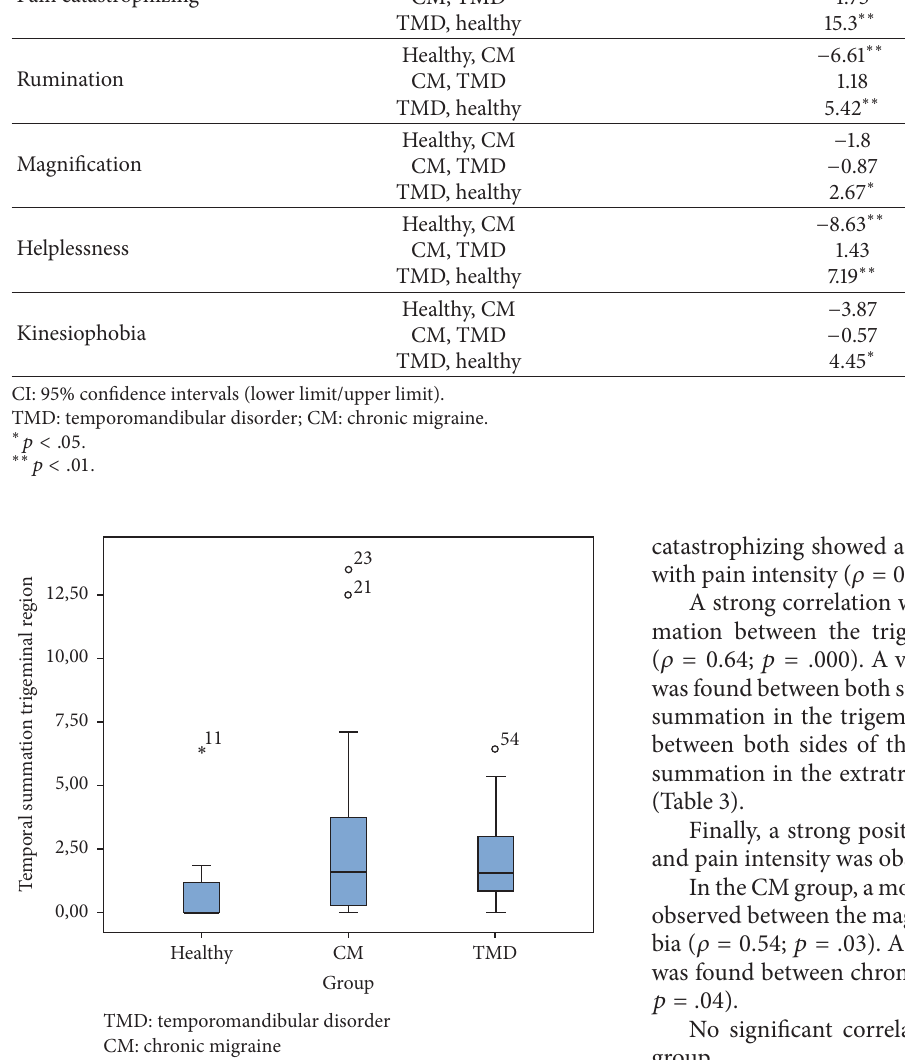
moderate and positive correlation with catastrophizing ( 𝜌 = 0.45 ; 𝑝 = .002 ) and kinesiophobia ( 𝜌 = 0.34 ; 𝑝 = .01 ).